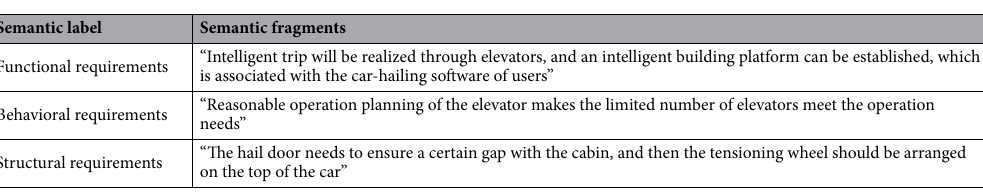
Table 1. A part of text